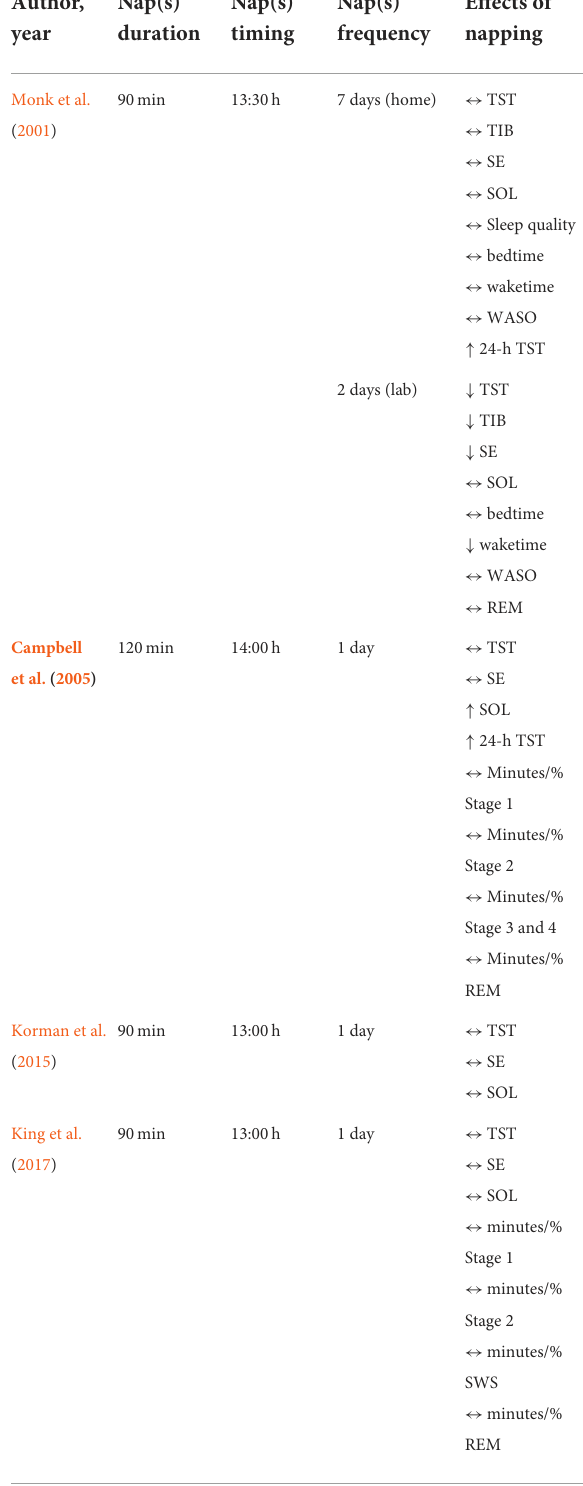
TABLE 7 The effects of napping on nighttime